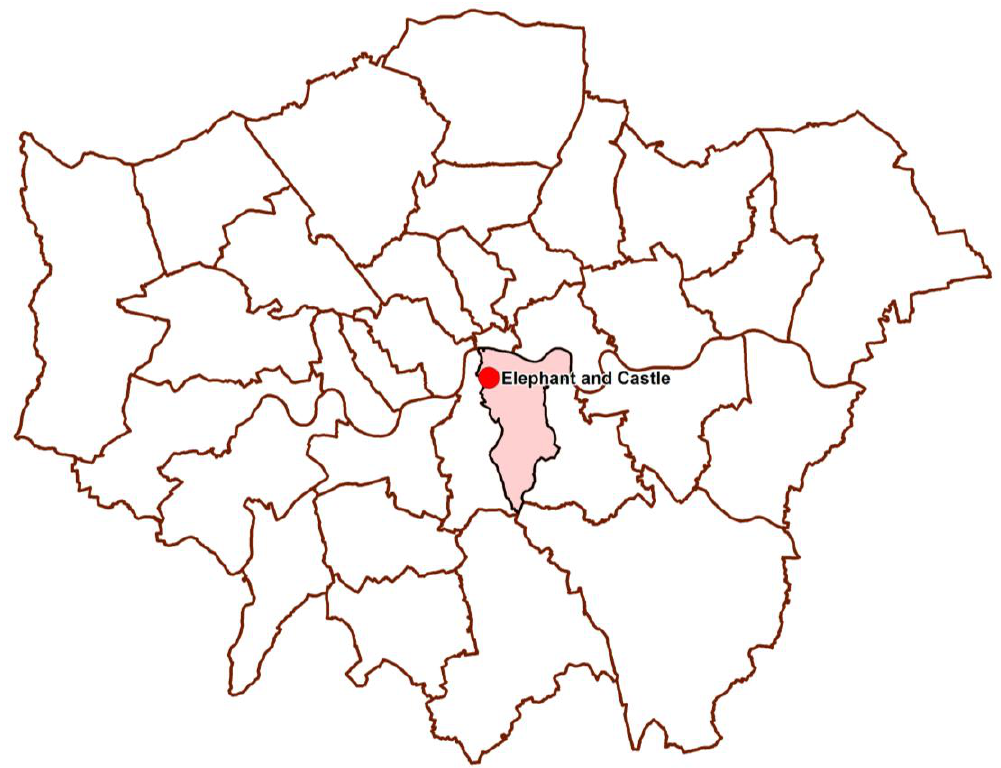
Figure 4. The figure describes Elephant and Castle, highlighted with a red dot in London Borough of